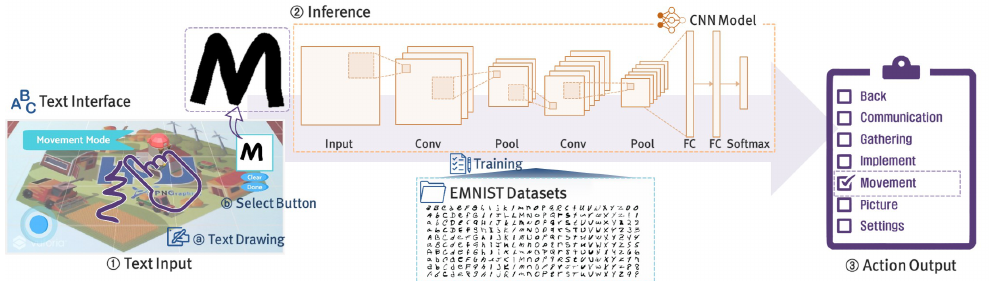
Figure 4. Text interface input method and the inference process using the deep learning